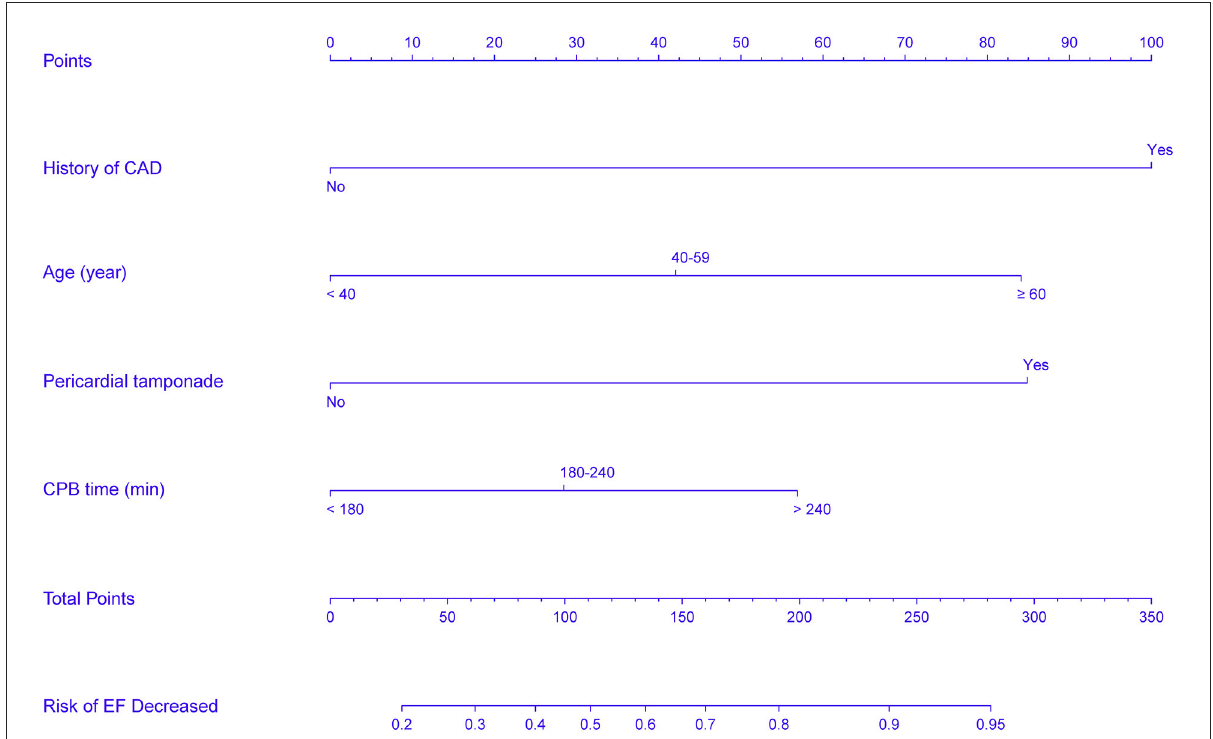
FIGURE3 Nomogram predicts EF reduction risk in patients with AKI undergoing CRRT after ATAAD surgery. The nomogram was established to predict the risk of decreased EF in patients with CRRT based on 4 independent prognostic factors. The value of each of variable wasgiven a score on the point scale axis. The total score can be calculated by summation of single scores. We can estimate the probability of decreased EF by projecting the total score to the lower total point